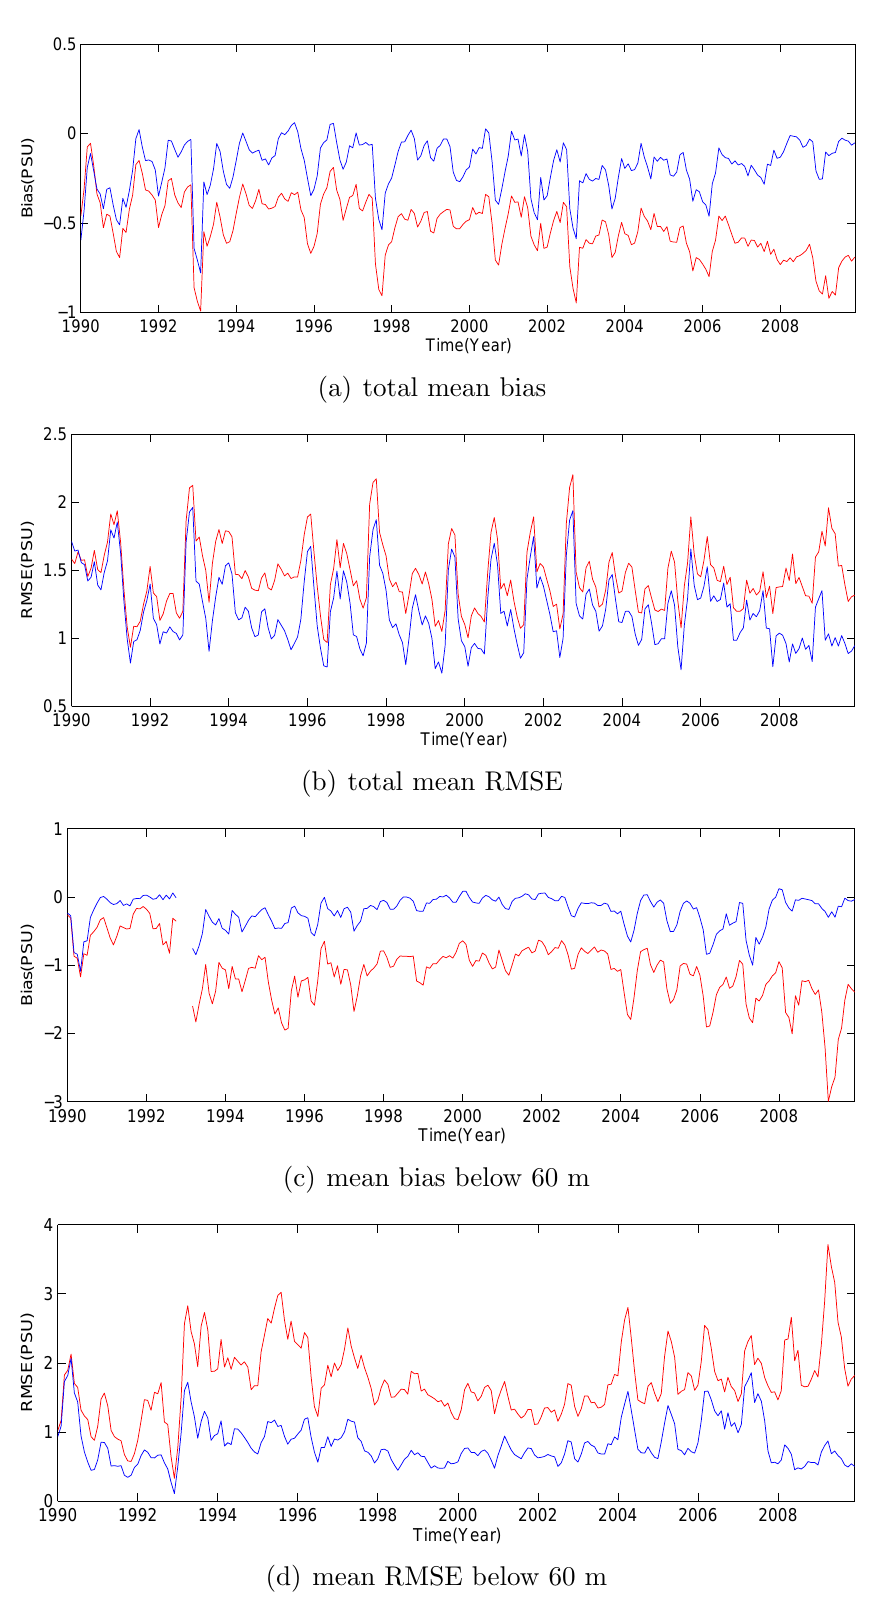
Fig. 9. The mean RMSE and bias of salinity calculated with monthly mean data from 1990 to 2009: (a) total mean bias, (b) total mean Figure 9: The mean RMSE and bias of salinity caculated with monthly mean RMSE, (c) mean bias below 60m, and (d) mean RMSE below 60m. The red is the free run and the blue is the reanalysis. data from 1990 to 2009: (a) total mean RMSE, (b) total mean bias, (c) mean RMSE below 60 m and (d) mean bias below 60 m. The red is the free run Ocean Sci., 8, 827–844, and the blue is the reanalysis.